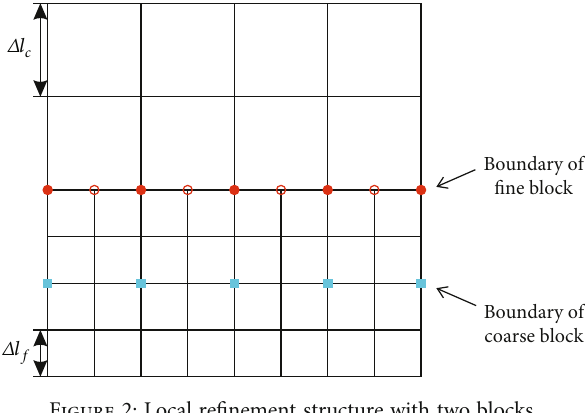
Figure 2: Local re fi nement structure with two